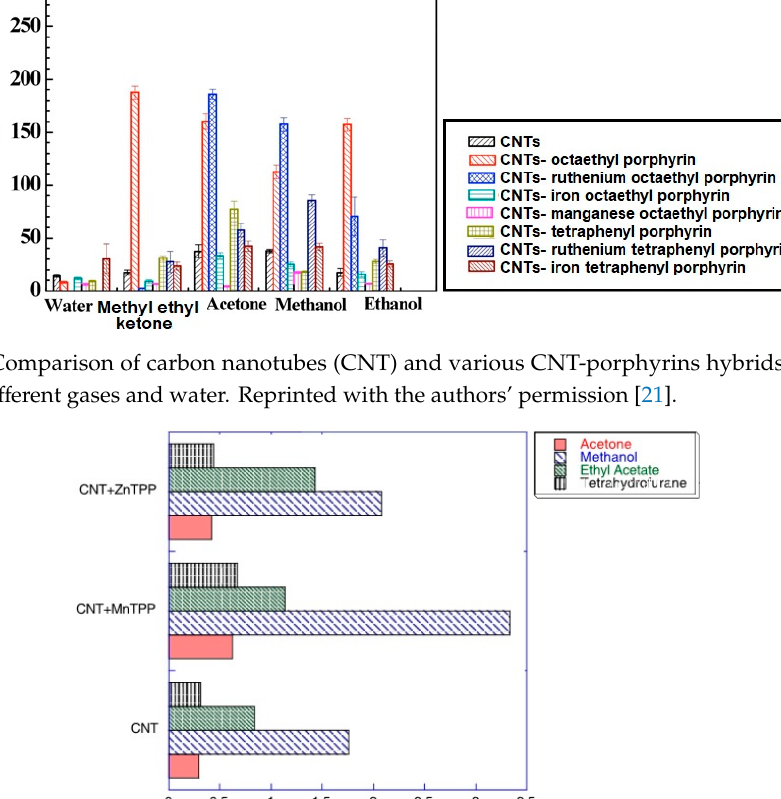
Figure 3. Comparison of carbon nanotubes (CNT) and various CNT-porphyrins hybrids responses towards different gases and water. Reprinted with the authors’ permission [21].